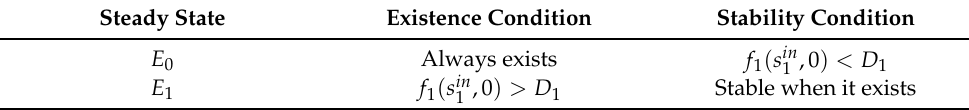
Table 1. Summary of the results of Proposition